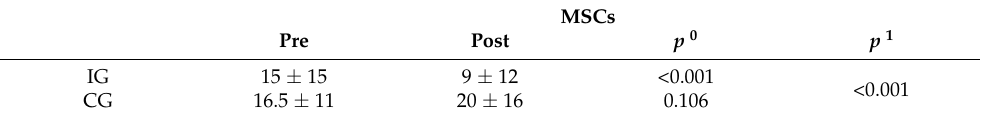
Table 3. MSCs before and after the intervention. Data are reported as median ± interquartile range.